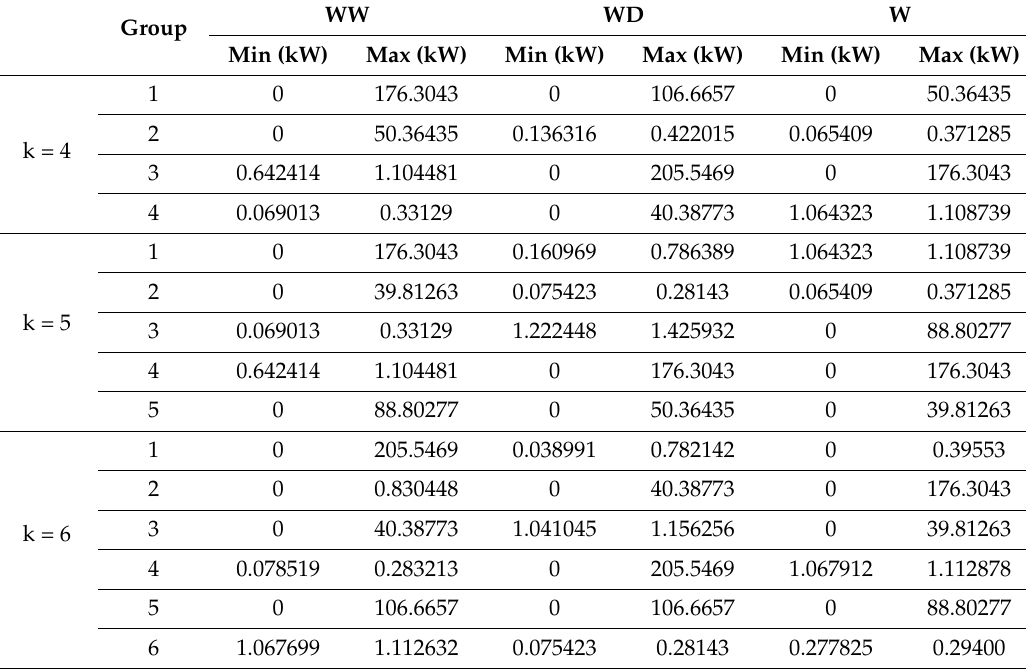
Table 5. Optimization results for k = 4 to k =